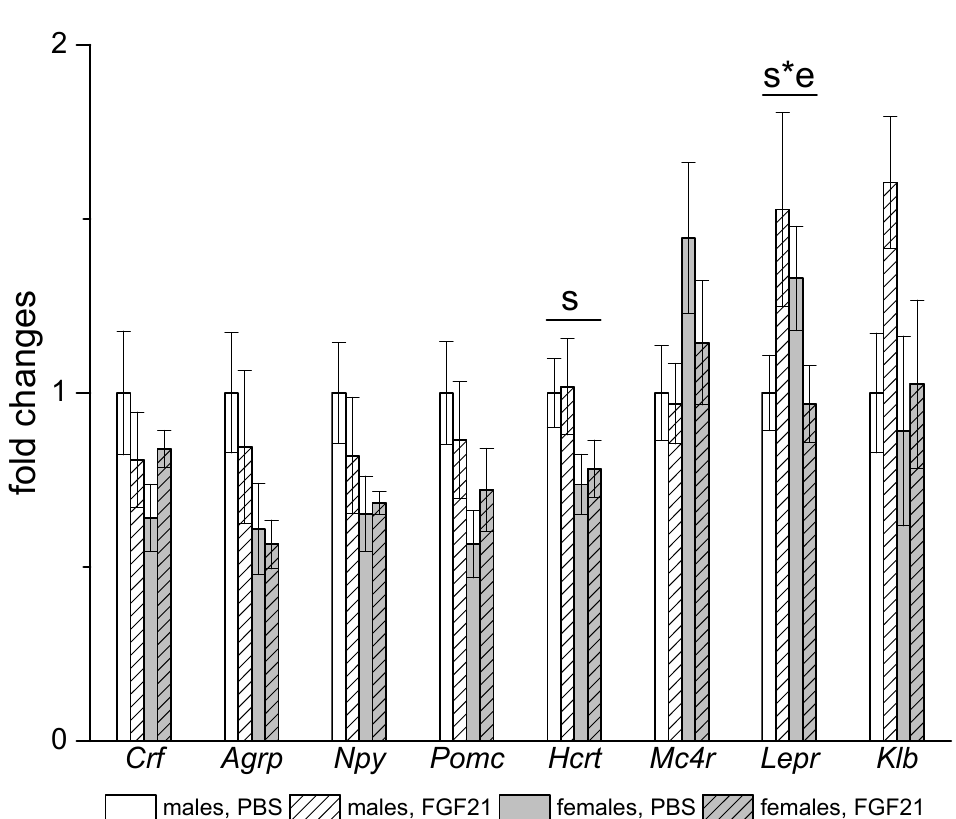
Figure 8. Influence of FGF21 administration on hypothalamic gene expression in obese A y male and female mice. Data are presented as mean ± SE. Mice were administered FGF21 for 7 days. Significant influence ( p < 0.05) of factors “s” (sex) and “s*e” where “e” is the administration of PBS or FGF21, two-way ANOVA are indicated in the plot.